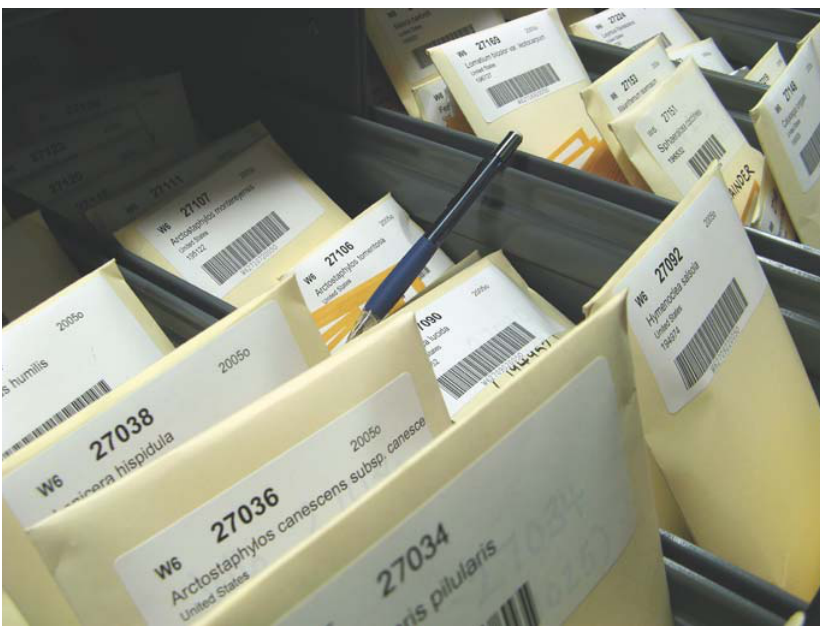
Figure 3. Storing Native